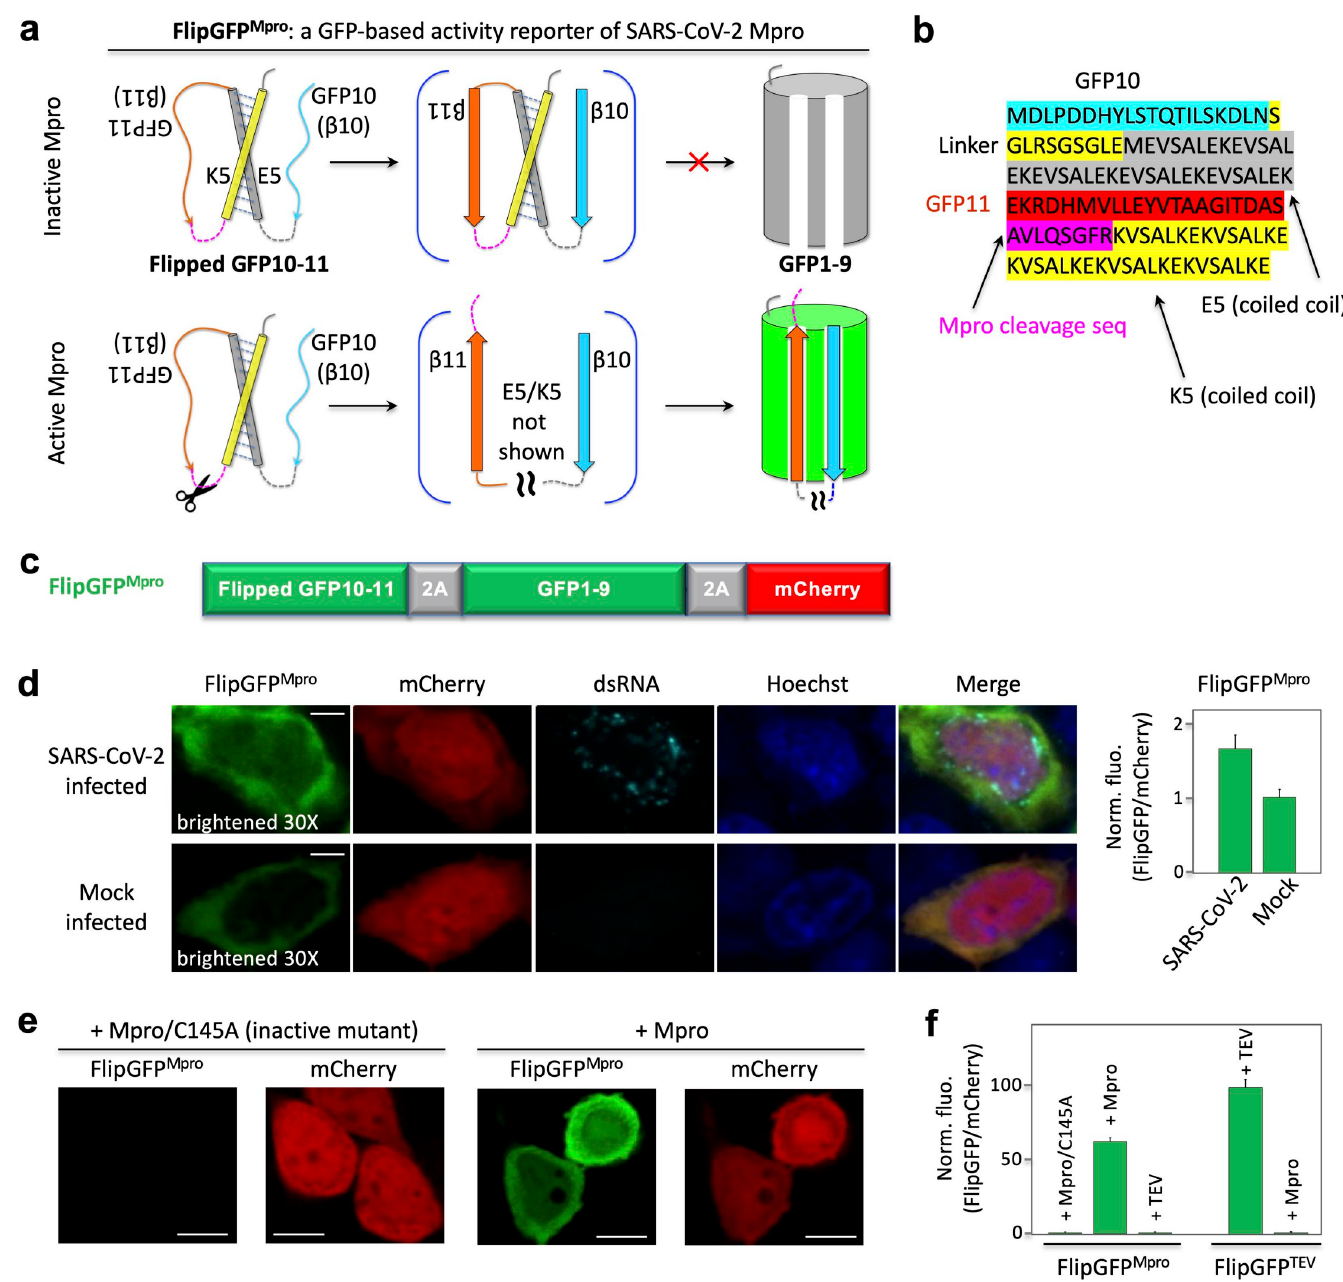
Fig 1. Design and demonstration of a GFP-based activity reporter of SARS-CoV-2 main protease Mpro. (a ) Schematic of the reporter. ( b ) Sequence of the flipped GFP10-11. ( c ) Construct of the reporter FlipGFPMpro. ( d ) Fluorescence images (left) and quantitative analysis (right) of SARS-CoV-2 or mock-infected HEK293T cells that co-expressed hACE2. The images in the FlipGFP channel were brightened 30-fold compared to those in ( e ). ( e ) Fluorescence images of HEK293T cells expressing FlipGFPMpro and mCherry, together with the inactive Mpro mutant C145A (upper panels) or wild type Mpro (lower panels). ( f ) Normalized FlipGFP fluorescence by mCherry. The ratio of FlipGFP/mCherry for the Mpro/C145A is normalized to 1. Data are mean ± SD (n = 5). FlipGFPTEV is a TEV activity reporter containing TEV cleavage sequence in FlipGFP. Scale bar: 5 μ m ( d ); 10 μ m ( f ). https://doi.org/10.1371/journal.ppat.1009898.g001 drugs at a lower concentration (10 μ M) and found that 12 drugs showed � 50% reduction of FlipGFP Mpro fluorescence (normalized by mCherry) at 10 μ M concentration ( Fig 2B ). We finally calculated an IC for each of the 12 drugs. IC of six drugs were at 2–6 μ M ( Fig 2C ), 50 50